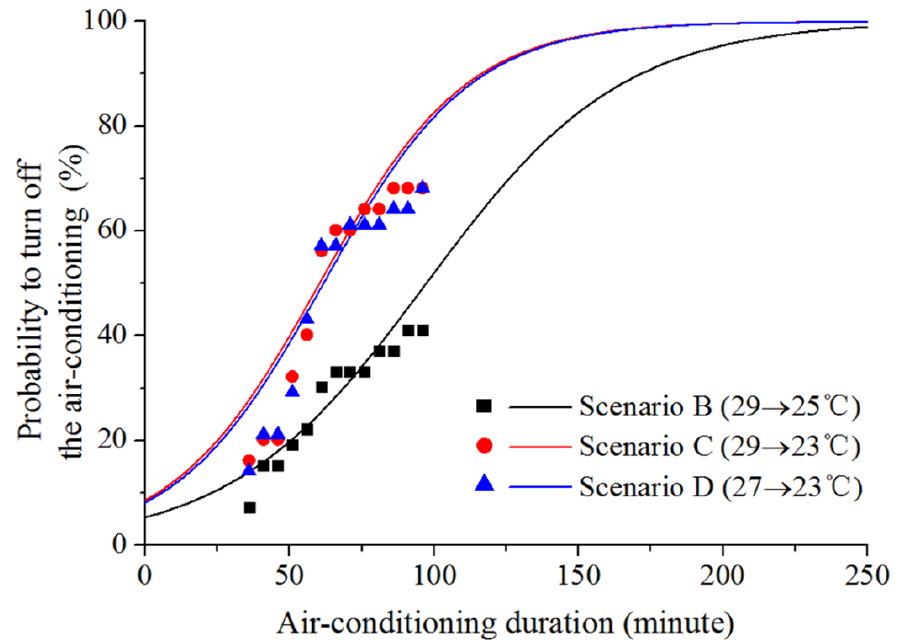
Figure 13. The probability to turn off the air conditioning as a function of the air conditioning dura- tion. (The scatter points represent the probability with air conditioning off intention in scenarios B, C and D). Table 5. Results of the characteristic parameters of logistic regression for three experimental scenarios.